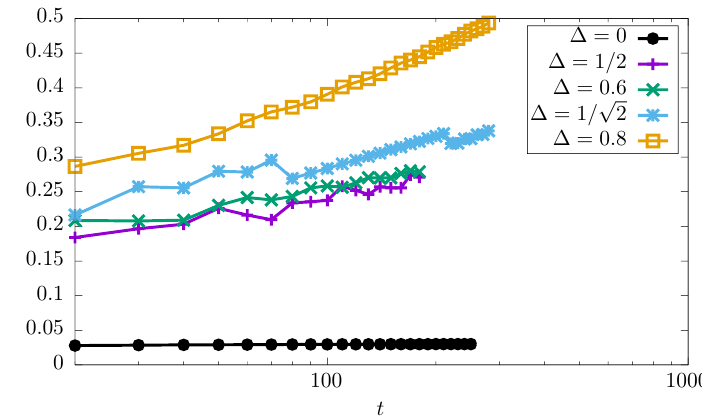
Figure 9: Particle number N in the diluted region [ x , ∞ ) on the right of the GHD dil e edge, as a function of time (on a logarithmic scale). Data is shown for several values of ∆ . The results are consistent with a slow logarithmic divergence of this particle number, except at the free fermion point, ∆ = 0, where it saturates very quickly. = t . In stark contrast, the free fermion T-W distribution is concentrated on a the way to x f much smaller region of width t 1 / 3 near the free edge (which coincides with the GHD edge, since ∆ = 0 in that